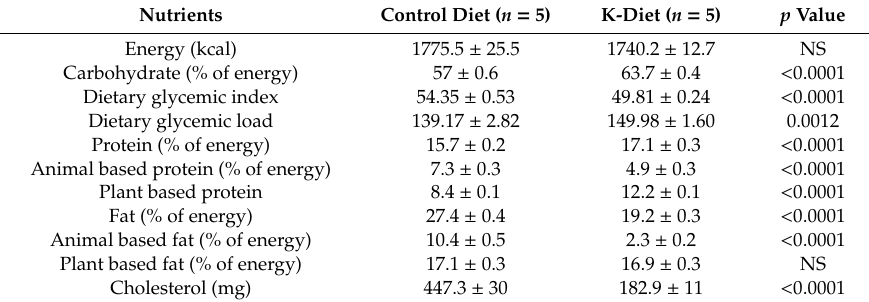
Table 3. Comparison of macronutrient intake between the K-diet group and control.